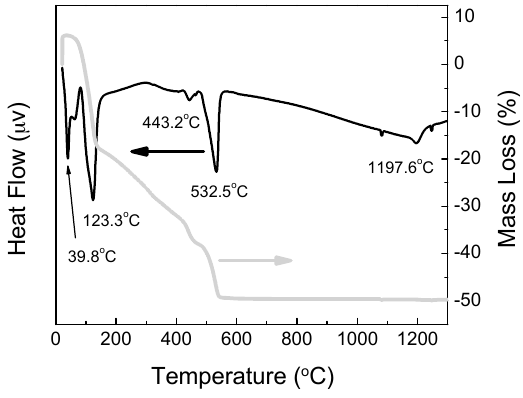
Figure 1. DTA/TG of the as prepared powders.